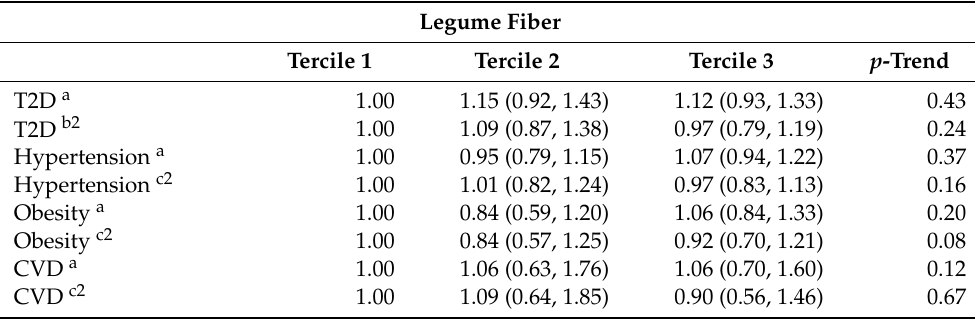
Table 4. Multi-variable adjusted HR (95% CI) of T2D, hypertension, obesity, CVD, and all-cause mortality according to terciles of legume